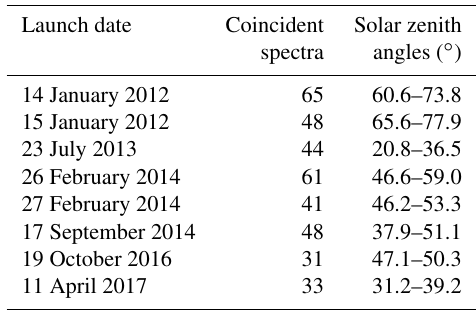
Table 3. AirCore launch dates and number of coincident spectra within ± 1h of the AirCore last sampling time and within ± 1.5h of the closest a priori time. The range of solar zenith angles covered by the coincident spectra is also